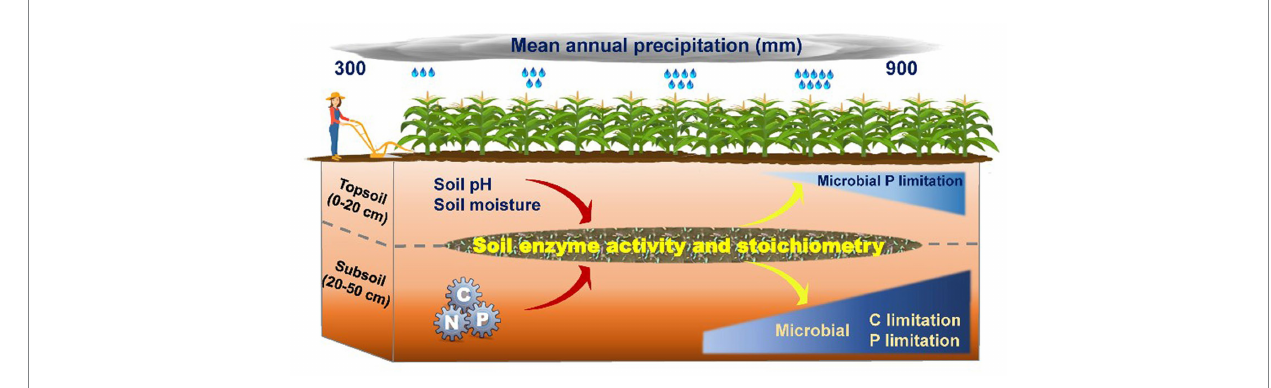
FIGURE 6 A conceptual framework of soil enzyme activity and stoichiometry along a precipitation gradient (300–900 mm) among soil profiles in agricultural ecosystems. Microbial C limitation, microbial carbon limitation; Microbial P limitation, microbial phosphorus limitation. pH, soil acidity and alkalinity; C, total carbon; N, total nitrogen; P, total